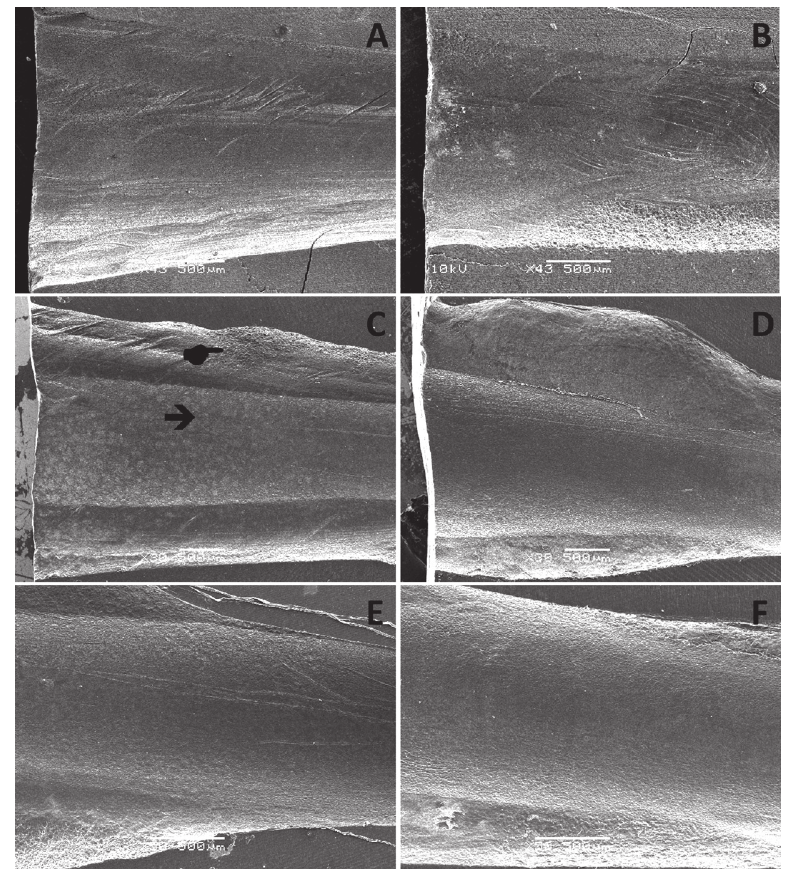
Figure 4- Photomicrographs of root dentin surface: A) canal prepared with manual files (43x); B) canal prepared with rotary files (43x); C) canal after manual and prosthetic preparation, cervical third (30x); D) canal after rotary and prosthetic preparation, cervical third (30x); E) canal after manual and prosthetic preparation, middle third (50x); F) canal after rotary and prosthetic preparation, middle third (50x). The indicator ( E ) shows the root region prepared with manual file; the indicator ( è ) shows the root region where the post space bur wore the dentine and eliminated the irregularities caused by manual